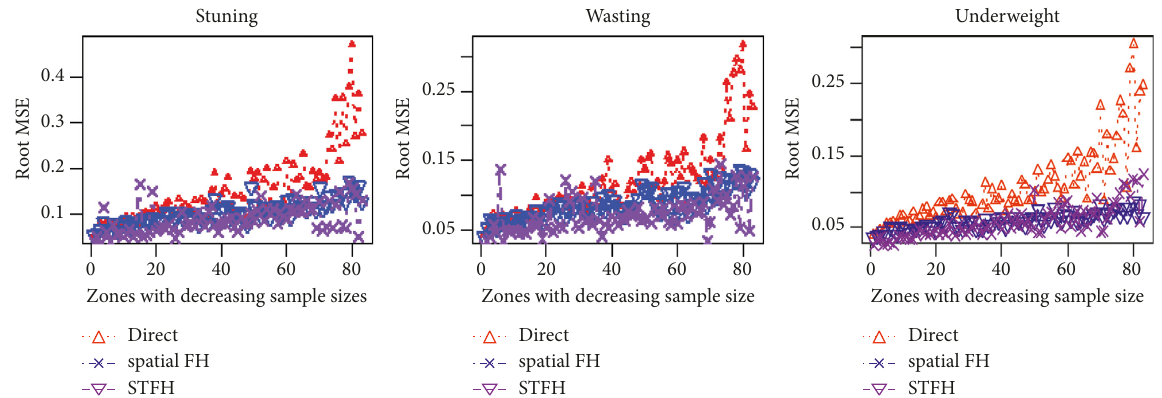
Figure 4: Zones (increasing sample size) Root MSE of direct and STFH estimators of stunting, wasting, and